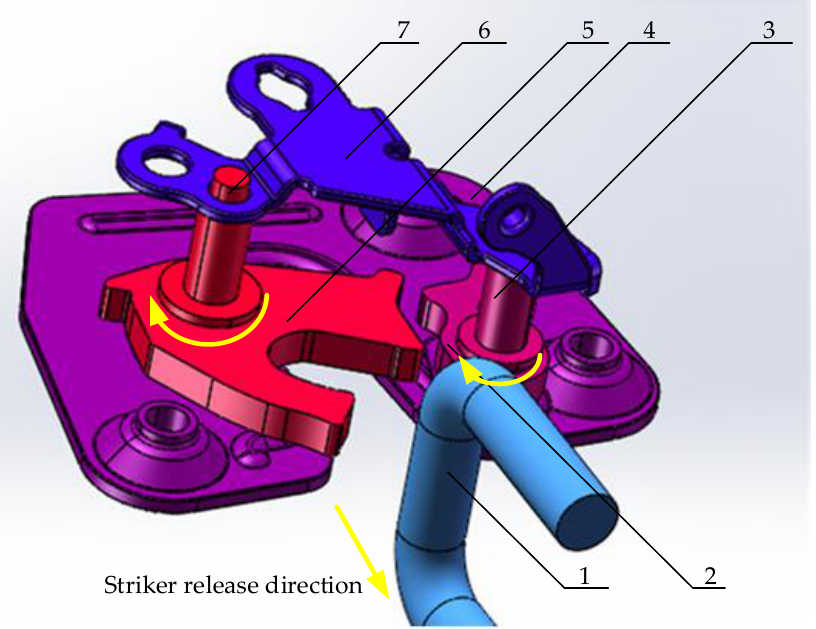
Figure 5. Schematic diagram of the disengagement of the latch and the striker. (1) Striker, (2) pawl, (3) pawl riveting shaft, (4) bottom plate, (5) fork-bolt, (6) auxiliary bottom plate, (7) fork-bolt riveting shaft.